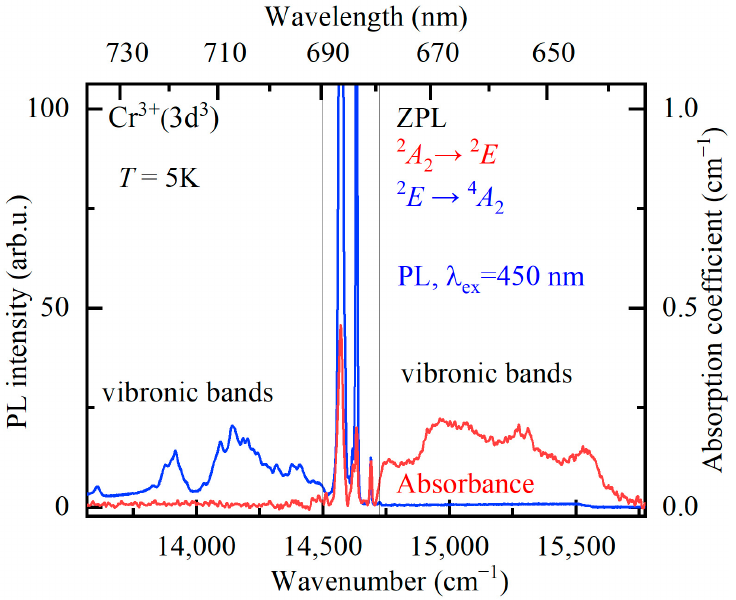
Figure 6. Absorption (red curve) and luminescence (blue curve, excitation wavelength λ ex = 450 nm) spectra of YAB:Mn at the temperature T = 5 K in the region (indicated by gray thin vertical lines) of zero-phonon R lines and the region of associated vibronic bands. Table 3. Energy values (cm − 1 ) of the 2 E, 2 T 1 (at 5 K), 4 T 2 , and 4 T 1 (at 77 K) levels of uncontrolled Cr 3+ in YAB:Mn determined from the absorption and excitation spectra.